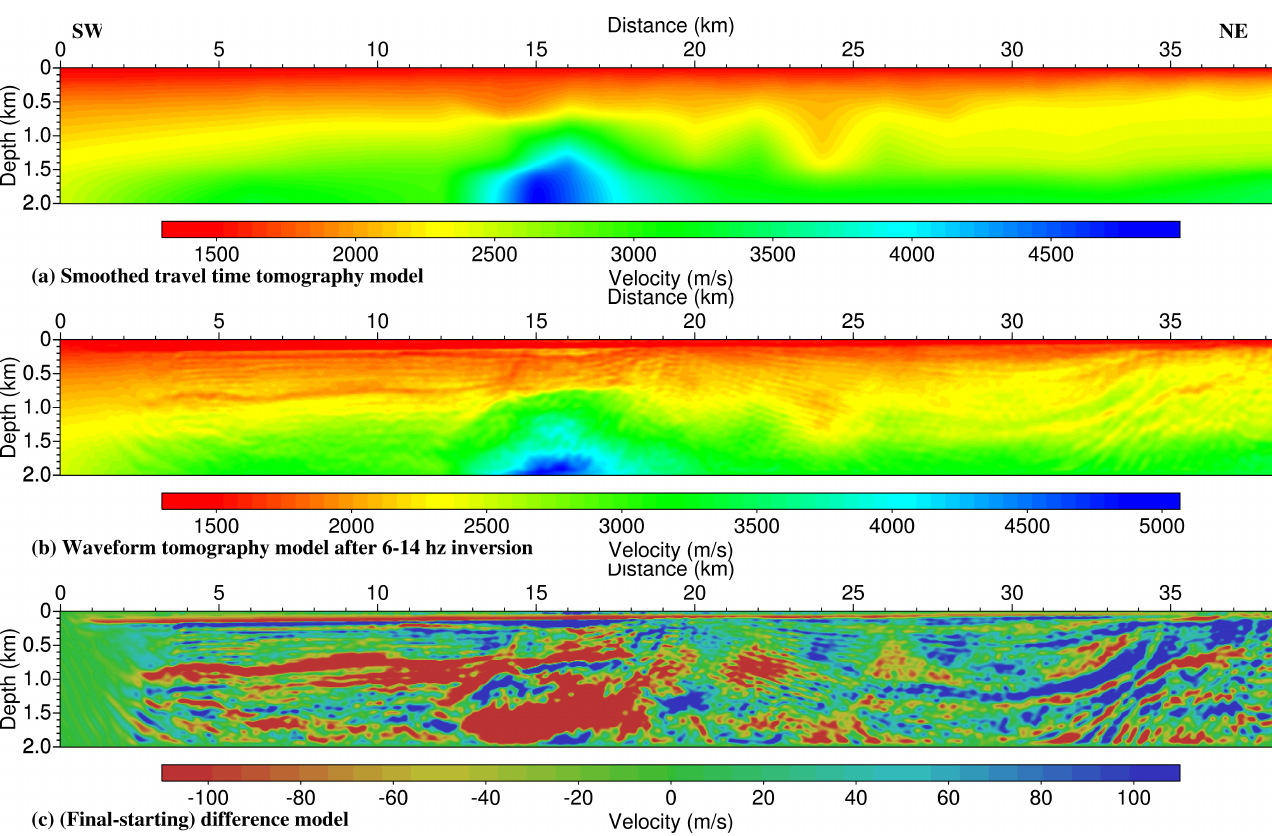
Figure 10. ( a ) Smoothed travel time inversion velocity model used as the starting model for the waveform inversion, ( b ) waveform inversion model after 6–14 Hz inversion, and ( c ) velocity anomaly model obtained by subtracting the initial model ( a ) from final model ( b ).